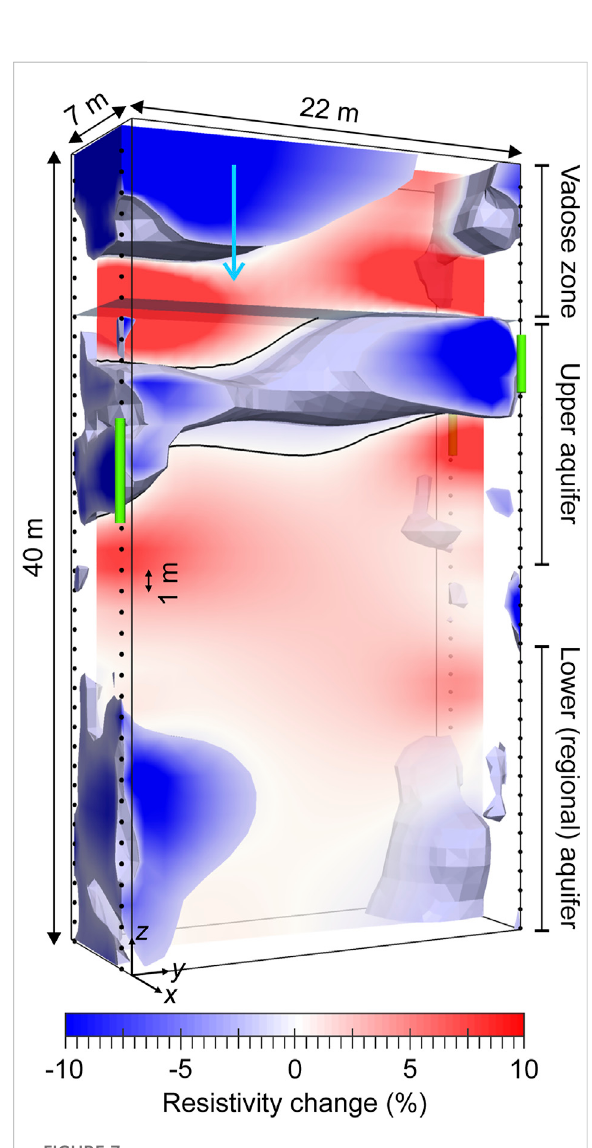
FIGURE 7 Annotated example distribution of fractional resistivity change in the imaging region bounded by the vertical borehole electrode arrays at MSSS. Blue arrow indicates tracer injection location, green cylinders show regions of historic contamination detected in borehole sediment cores (data © Sella fi eld Ltd.). Isosurfaces bound regions of resistive change below − 2%. Black line is the 0% change contour, assumed to delineate the preferential pathway reoccupied by the